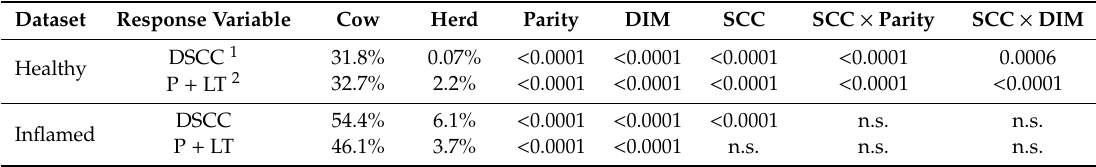
Table 2. Results of ANOVA analysis for repeated measures applied to the two subsets considered (healthy and inflamed).